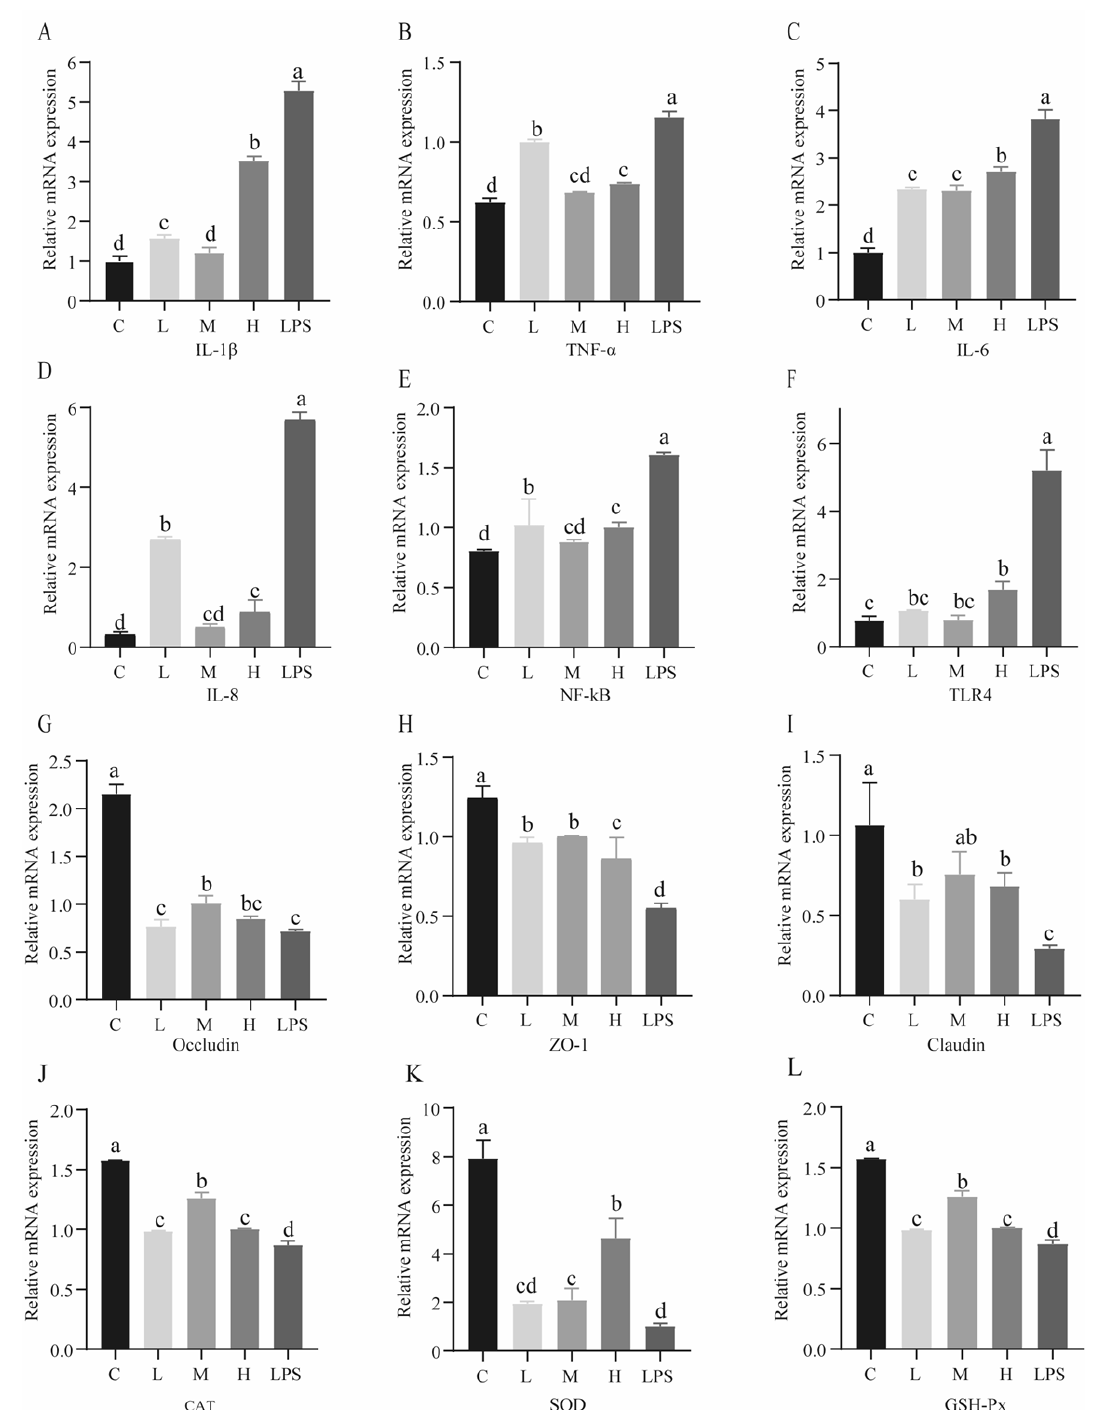
Figure 4. Effects of L. rhamnosus CY12 on mRNA expressions related to inflammation, TJ proteins, and antioxidant enzymes in LPS-induced Caco-2 Cells. ( A ): mRNA expression of IL- 1β. ( B ): mRNA expression of TNF- α. ( C ): mRNA expression of IL-6. ( D ): mRNA expression of IL-8. ( E ): mRNA expression of NF- κB. ( F ): mRNA expression of TLR4. ( G ): mRNA expression of occludin. ( H ): mRNA expression of ZO-1. ( I ): mRNA expression of claudin. ( J ): mRNA expression of CAT. ( K ): mRNA expression of SOD. ( L ): mRNA expression of GSH-Px. Note: C represents uninduced Caco-2 cells; L, M, and H represent LPS-induced Caco-2 cells co-incubated with 10 7 , 10 8 , and 10 9 cfu/mL L. rhamnosus CY12, respectively; LPS represents LPS-induced Caco-2 cells. Data were presented as mean ± SEM. Means with the different letters are significantly different p <